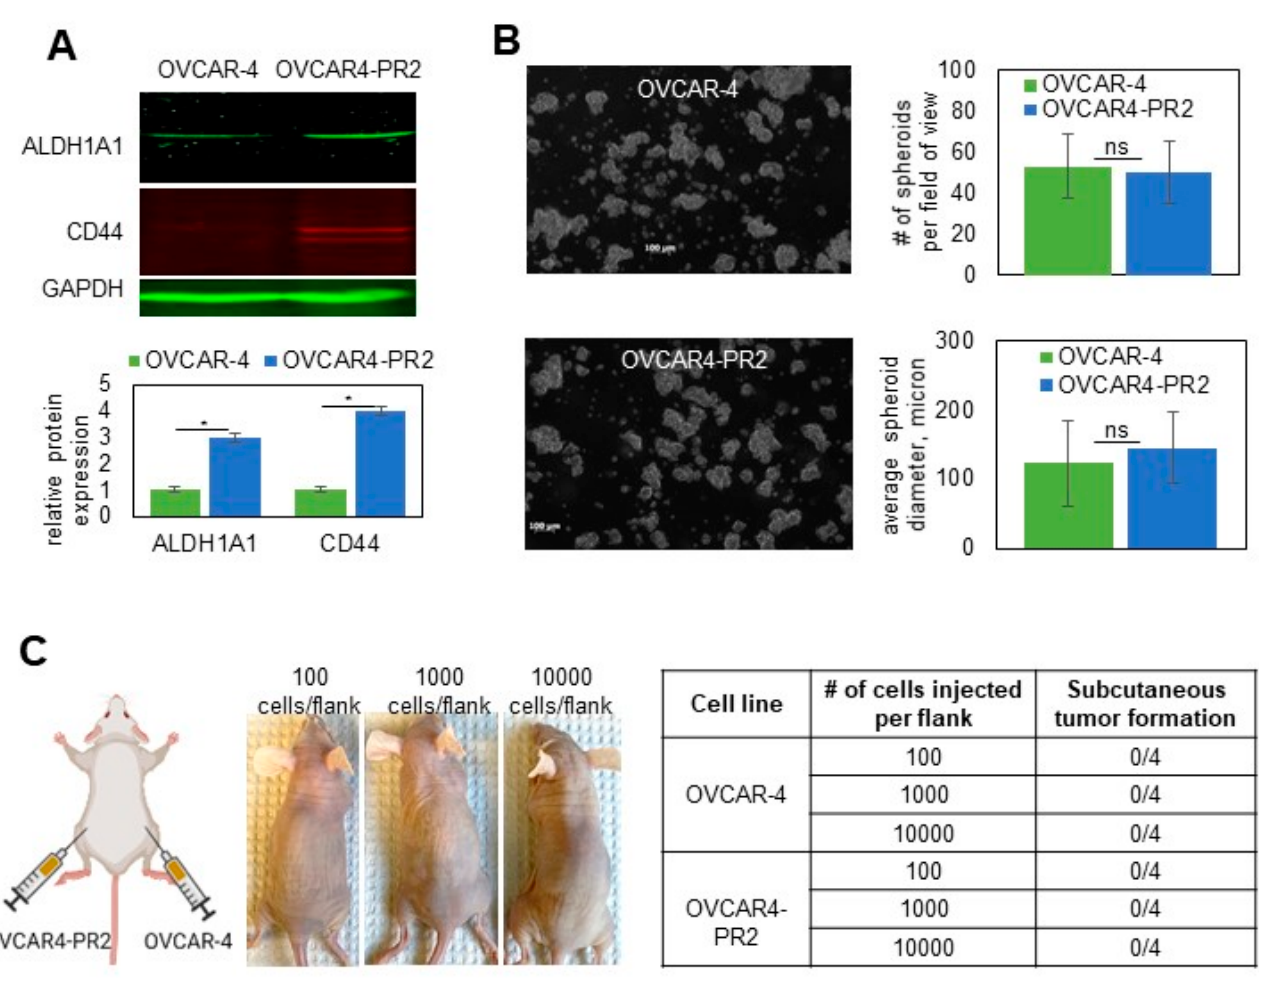
Figure 6. Examination of cancer-stem-cell-like characteristics of the isogenic pair of parental and paclitaxel-resistant OVCAR-4. ( A ) Expression of ALDH1A1 and CD44 in OVCAR-4 and OVCAR4-PR2 was examined with Western blot using antibodies at 1:250 and 1:500 dilution, respectively, measured with digital densitometry, plotted, and analyzed with Student’s t -test. * p < 0.05. GAPDH (1:200 dilution) was used as a loading control. The uncropped blots are shown in File S1. ( B ) OVCAR-4 and OVCAR4-PR2 (10 6 cells/P100 tissues culture plate) were subjected to spheroid formation assay for 48 h and imaged. The number and diameter of spheroids in the field of view at 5 × magnification on the objective were quantified in 10 random fields/plate in 3 independent experiments, averaged, plotted, and analyzed with Student’s t -test. ( C ) Scheme created in BioRender shows that OVCAR-4 were injected in the right flanks, and OVCAR4-PR2 were injected in the left flanks at 100 cells/flank, 1000 cells/flank, and 10,000 cells/flank and observed for tumor formation for 15 months. Images of mice after 15 months of observation demonstrate that animals did not develop subcutaneous tumor nodules by the end of the experiment, which is reflected in Table 1.